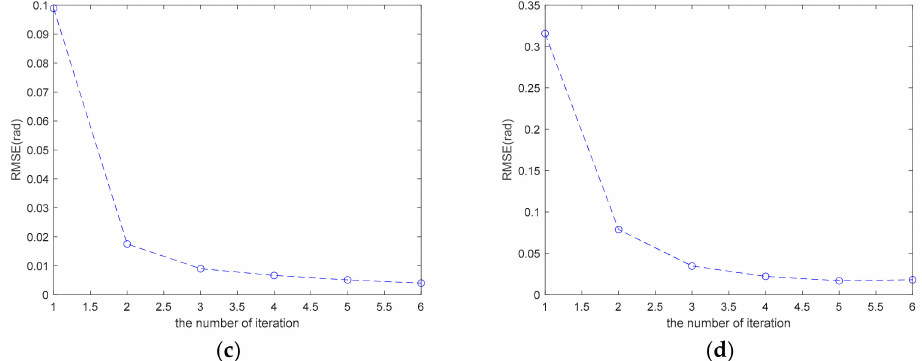
Figure 20. The RMSE of the estimated vibration phase values with different numbers of iterations: ( a ) Under condition 1; ( b ) under condition 2; ( c ) under condition 3; ( d ) under condition 4.